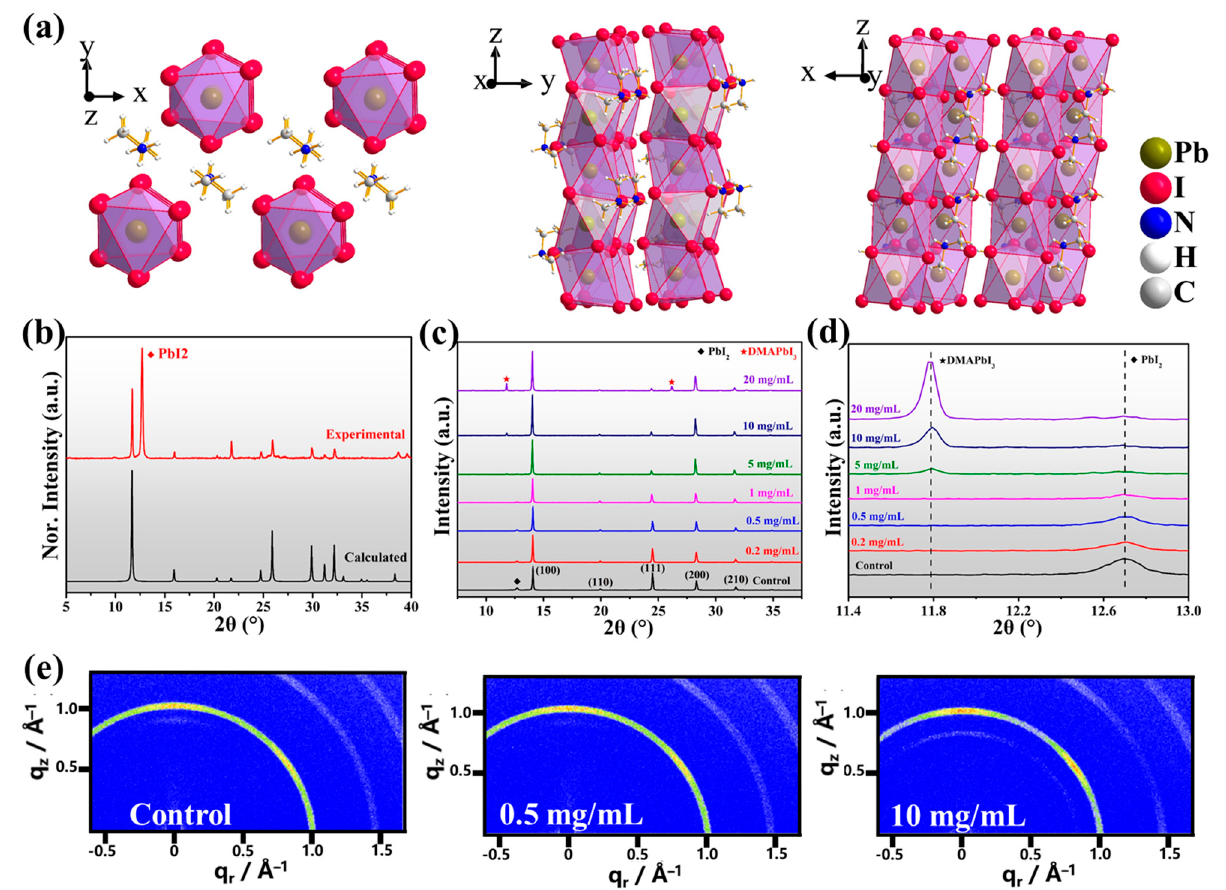
Figure 1. ( a – c ) Crystal structure of 1D DMAPbI 3 perovskite along different directions. ( b ) Comparison of the calculated and experimental XRD patterns of DMAPbI 3 . ( c , d ) XRD patterns of perovskite films treated with different concentrations of DMAI. ( e ) GIWAXS images of three typical samples: control, 0.5 mg/mL representing low concentration, and 10 mg/mL representing high concentration.